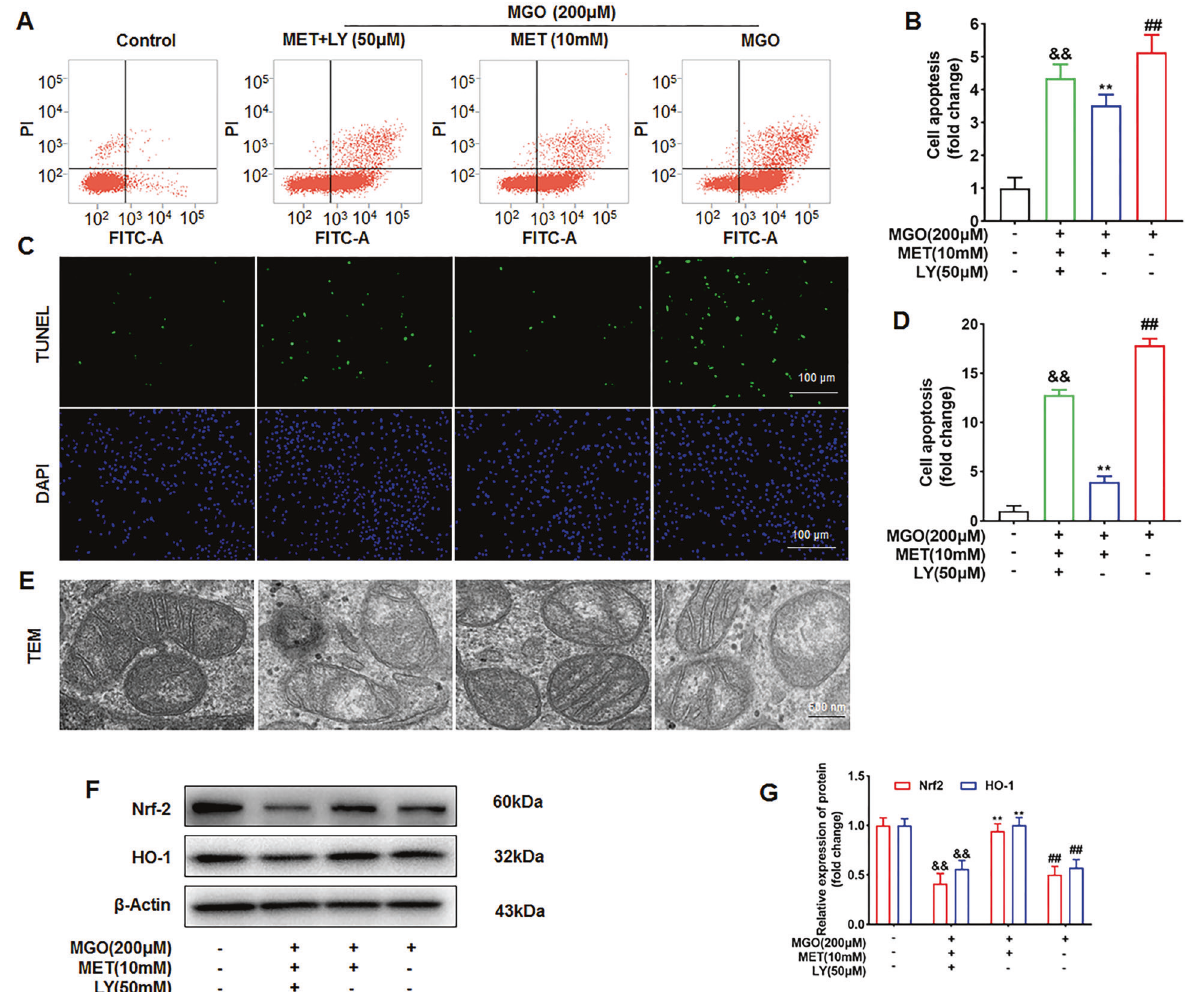
Fig. 4 MET suppresses MGO-induced apoptosis and Akt dephosphorylation. HUVECs were pretreated with MET (10 mM), LY-294002 (LY, 50 μ M, a PI3K inhibitor), and the vehicle control for 2 h, followed by stimulation with MGO for 24 h. A , B Cell apoptosis was analyzed by fl ow cytometry based on Annexin V-FITC and PI double staining. C , D Cell apoptosis was also examined by the TUNEL assay. Scale bars, 100 μ m. Representative images of cell apoptosis are shown. E Ultrastructural alterations of mitochondria were detected by TEM. Scale bars: 500 nm. F , G Representative western blots of total cell lysates after immunoblotting and probing with antibodies against Nrf2 and HO-1, which were quanti fi ed by densitometry and calculated as ratios to β -Actin. The values (mean ± SD from three independent experiments) are relative to the control and are expressed as fold changes. ## p < 0.01 vs. Control, ** p < 0.01 vs. MGO, && p < 0.01 vs. MGO +